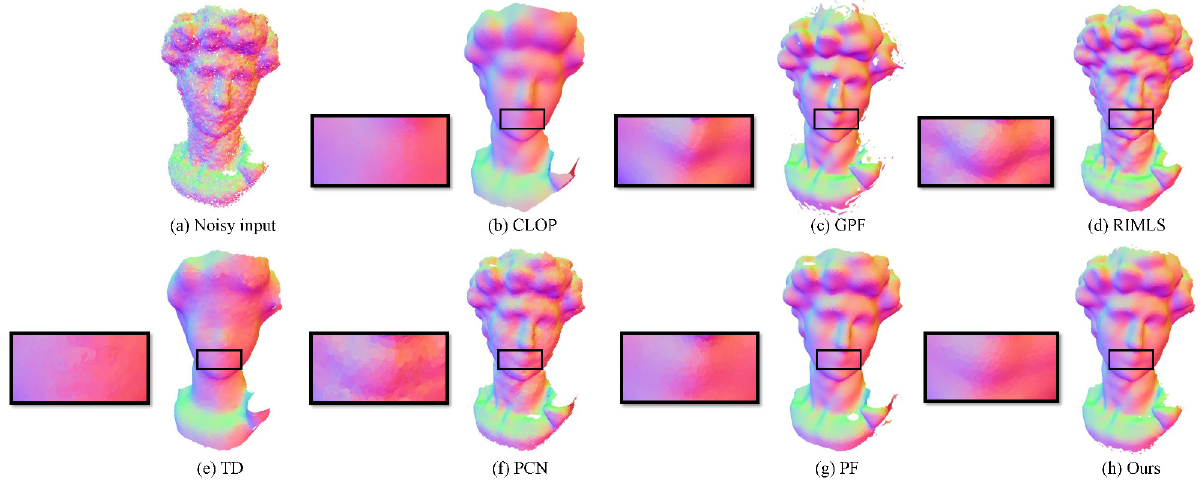
Fig. 12 Upsampling results on the David raw scanned model.